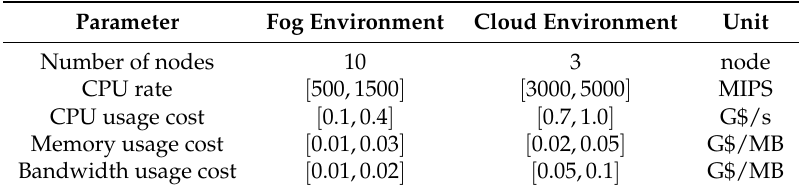
Table 3. Characteristics of the Cloud–Fog infrastructure.